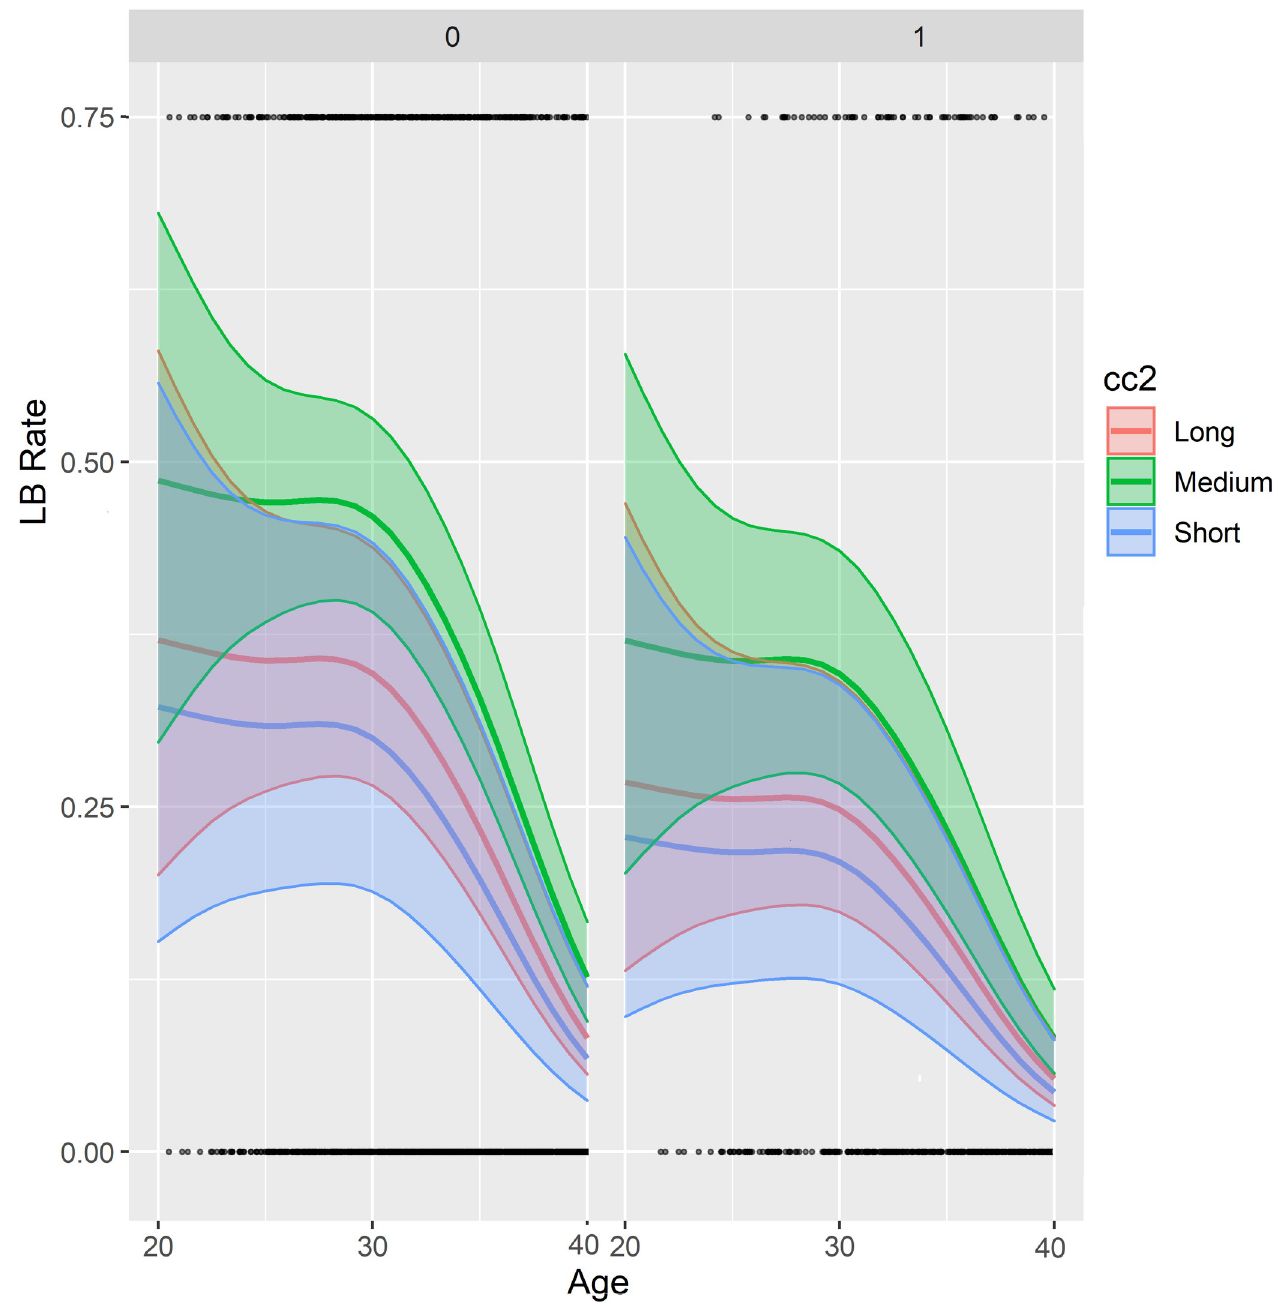
Fig 8. GAMM model fit regarding live birth relative to age, second cell cycle (cc2) duration (long, medium, short) and nucleation error. The nuclear errors occur on the right side of the figure. The 95% confidence interval (CI) are outlined in red, green, and blue.